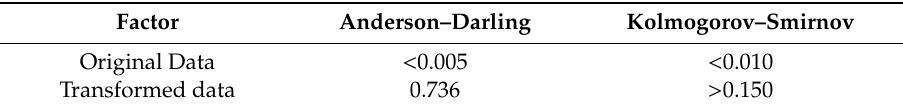
Table 3. The p -values of tests for normality of Ra .